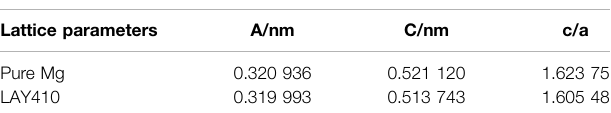
TABLE 2 | Lattice parameters of α